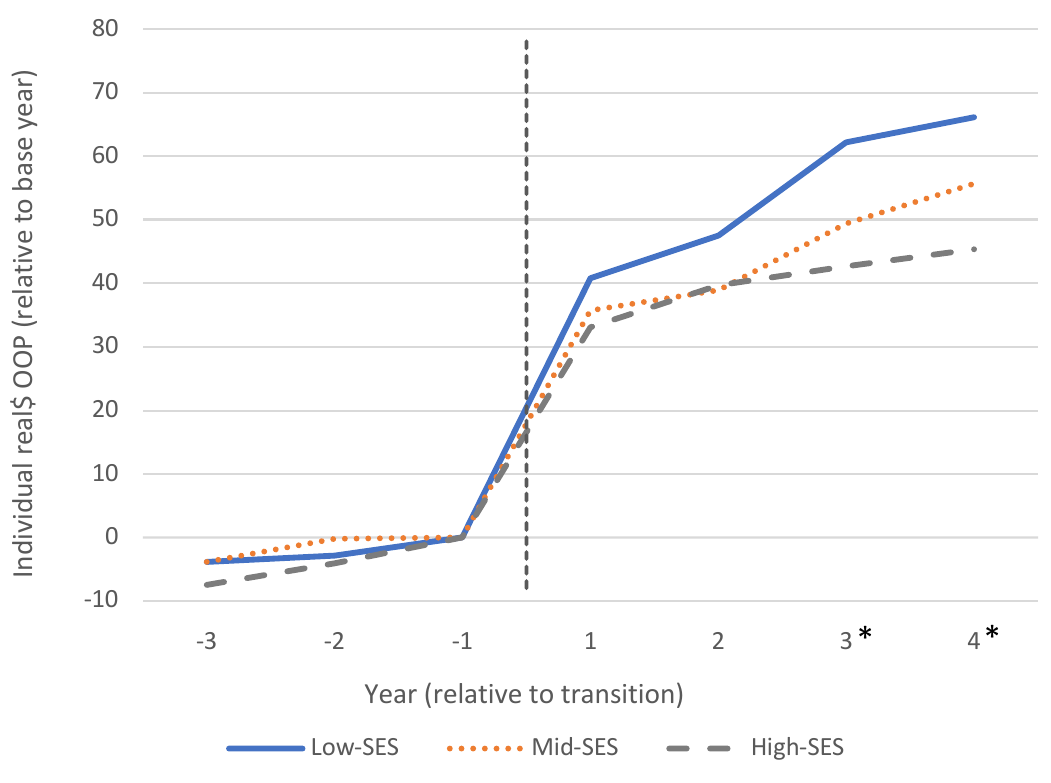
Figure 3: Estimated effects of choice devolution on mean annual OOP medical expenditure burdens by enrollee SES. Notes: This figure shows pooled difference-in-difference estimates of changes in OOP medical expenditures among enrollees at firms that transition to devolved choice of insurance deductible level. SES categories correspond to the bottom 25 percent, middle 50 percent, and top 25 percent of the sample distribution. The model is estimated with year-fixed effects and with person-fixed effects centered at the pre-devolution level. ∗ indicates a statistically significant difference between the high- and low-SES groups at p <